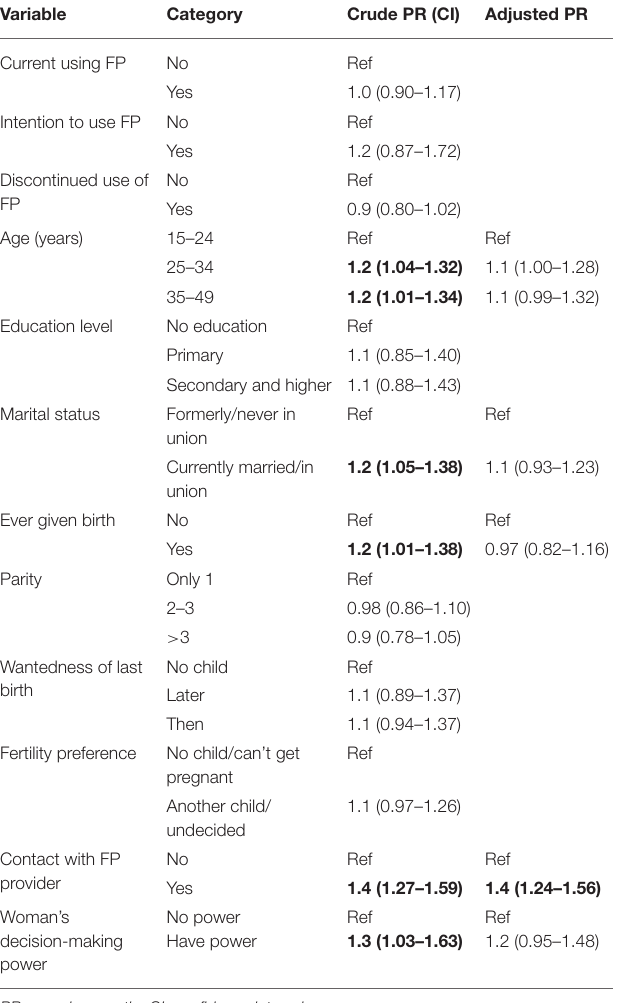
TABLE 5 | Factors associated with exposure to family planning messages through media*. Variable